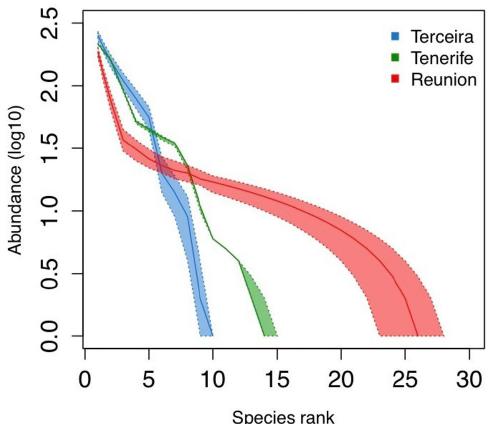
Figure 3. Geometric series rank-abundance plots for woody plants in Terceira, Tenerife, and Reunion. Rarefaction with 1000 randomizations was performed to the same number of individuals as in the island with a lower overall abundance. Averages and 95% confidence limits envelopes for curves (a) and 95% confidence limits for slopes (b) are presented. OLS regression equations and goodness-of-fit values: Terceira: y =-0.304 x + 2.999, R 2 = 0.937; Tenerife: y =-0.150 x + 2.459, R 2 = 0.985; Reunion: y =-0.031 x + 1.630, R 2 = 0.960.